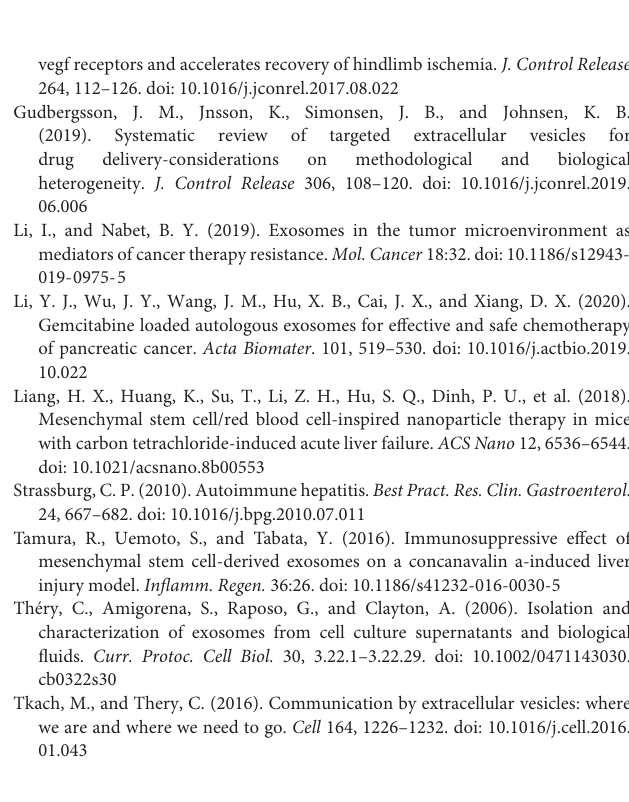
Supplementary Figure 2 | The original data of Figure 1G . Western blotting analysis of Exo and Exo@DEX by ProteinSimple Wes TM capillary western blot analyzer. Supplementary Figure 3 | Characterization of MSCs. Flow cytometry analysis of MSC markers. Supplementary Figure 4 | HPLC analysis of DEX. HPLC analysis of the incorporation of DEX into Exos. Supplementary Figure 5 | Cellular internalization of Exo@DEX. Representative fluorescence images of Exo uptake by RAW264.7 macrophages and L02 liver cells in vitro (images were enlarged, indicated by a white dotted box). Cells were incubated with Exo-free supernatant (Supernatant) or DiD-labeled Exo@DEX (Exo@DEX). Supplementary Figure 6 | Measurement of cytokines in supernatants. ELISA-based measurement of TNF- α , IFN- γ , and, IL-1 β (pg/mL) in supernatants prepared from the culture medium after each different treatment ( n = 5 for each group). Data are presented as the mean ± SD and were assessed via one-way ANOVA (**** P < 0.0001). Supplementary Figure 7 | Location of in vivo EXO@DEX in macrophages. Presence of Exo@DEX in the liver specimen and their localization in FITC-labeled F4/80-positive macrophages after the injection of DiD-labeled Exo@DEX (white arrow) (red: DiD-labeled Exo@DEX, green: FITC-labeled F4/80 macrophages, and blue: DAPI-labeled cell nuclei). Supplementary Figure 8 | Levels of DEX measured in the liver. Mice were sacrificed 2 h after administration of DEX (0.5 mg/kg) or Exo@DEX (5 mg/kg). Levels of DEX in the liver were measured by HPLC. Data are presented as the mean ± SD and were assessed via two-tailed unpaired Student’s t -test (*** P < 0.001). Supplementary Figure 9 | Flow cytometry analysis of macrophage apoptosis in the liver. (A) Gating of F4/80-positive cells. (B) Flow cytometry analysis of annexin V-and-PI staining of F4/80-positive cells from single-cell suspension of the